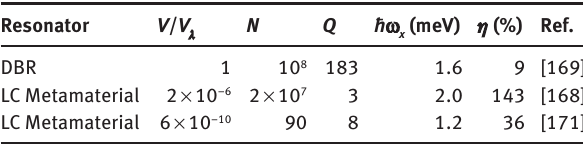
Table 4: Figures of merit for representative Landau polariton resonators. Resonator